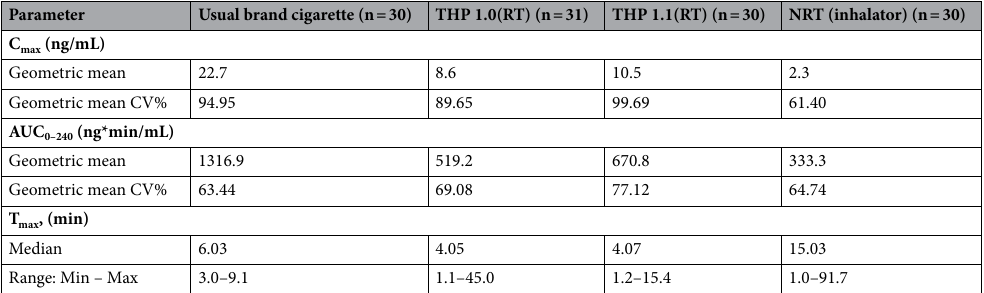
Table 2. Plasma nicotine pharmacokinetic parameters measured among adult smokers following 5-min ad libitum use of the glo THP, usual brand cigarette or NRT. Seven subjects were excluded from the PK analysis population due to major protocol deviations (washout problem), therefore n = 30 for usual brand cigarette, n = 31 for glo THP1.0(RT), n = 30 for glo THP1.1(RT) and n = 30 for Nicorette 15 mg Inhalator. CV coefficient of variation, Max maximum, Min minimum, THP tobacco heating product, NRT nicotine replacement